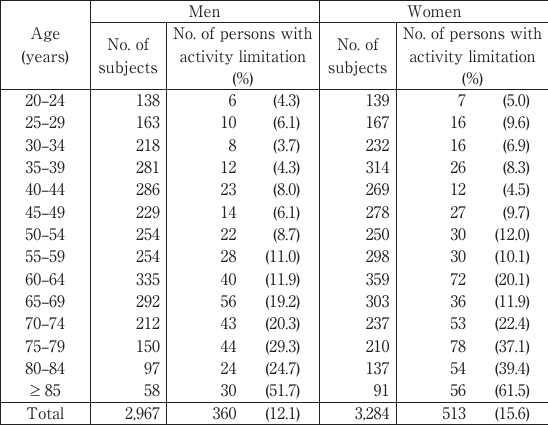
Table 1. Number of subjects and of persons with activity limitation by age